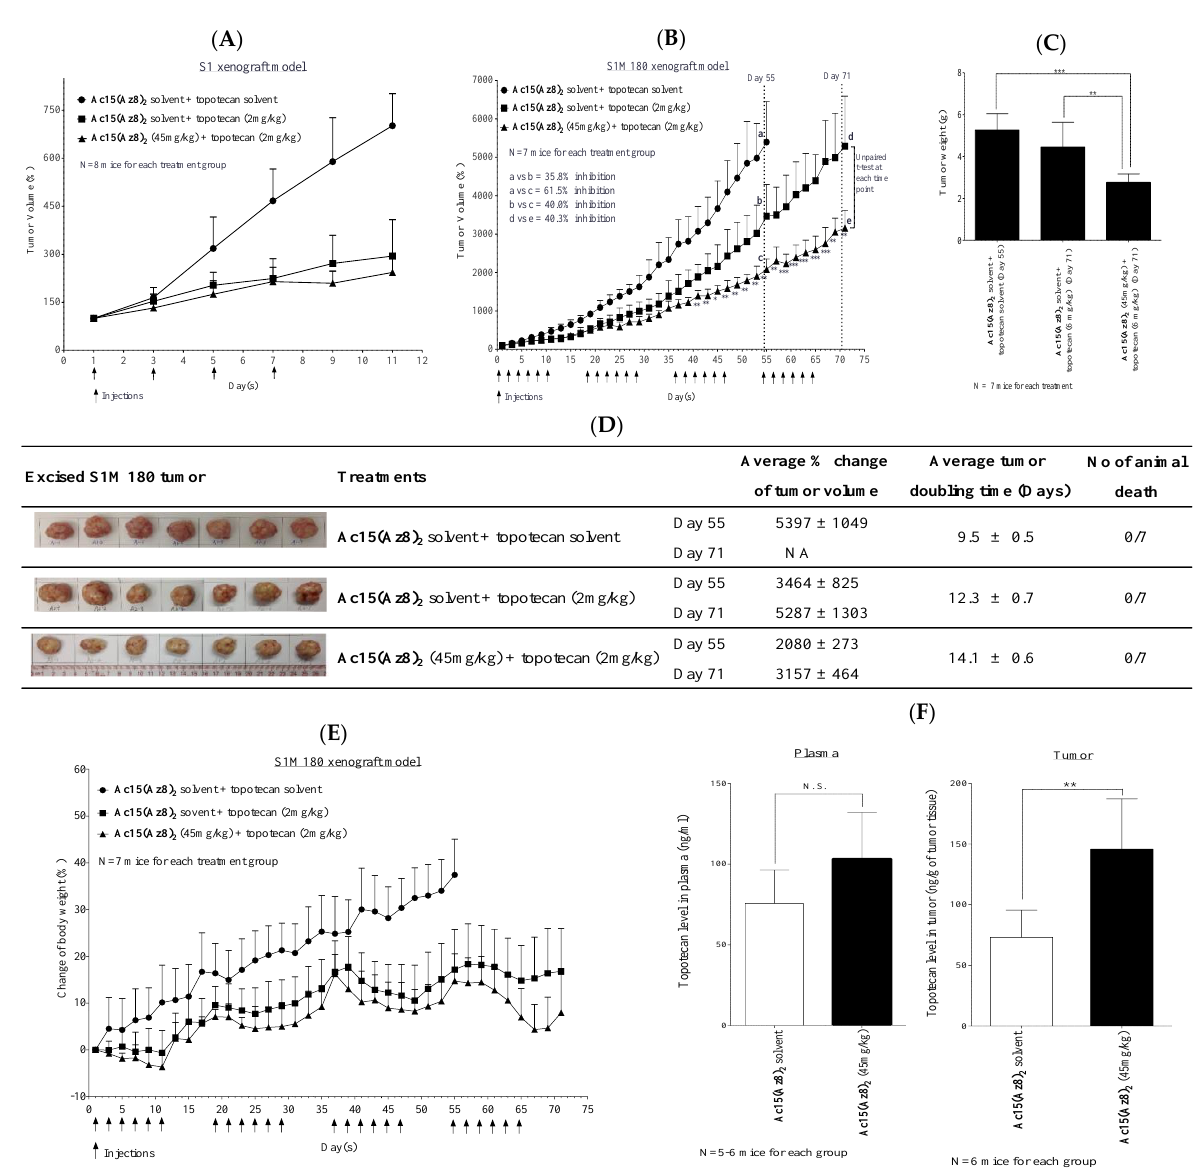
Figure 8. In vivo efficacy of Ac15(Az8) 2 in reversing BCRP-mediated topotecan resistance in S1M180 xenograft. ( A ) S1 xenograft. ( B ) S1M180 xenograft. There were 3 treatment groups in S1 and S1M180 xenograft model. Treatments were given as indicated by an arrow ( ↑ ). % of tumor volume reduction was compared among different treatment groups on days 55 and 71. a, b, and c = mean tumor volume of solvent control, topotecan alone, and combination treatment groups on day 55, respectively. d and e = mean tumor volume of topotecan alone and combination treatment groups on day 71. ( C ) Tumor weight of S1M180-bearing mice on termination day. ( D ) % change of tumor volume and tumor doubling time of S1M180 xenograft were determined on days 55 and 71. On day 55, all mice in solvent treatment group were sacrificed because of over-sized tumor. The % change in tumor volume of solvent group on day 71 was therefore labeled as NA (not applicable). Number of animal death was monitored during the efficacy study. ( E ) Body weight of S1M180-bearing mice. ( F ) To measure plasma and intratumor level of topotecan, S1M180-bearing mice were administered with 45 mg/kg (I.P.) of Ac15(Az8) 2 one hour prior to 6 mg/kg (I.P.) of topotecan administration. Five hours after topotecan administration, the mice were sacrificed. Plasma and tumor were collected for analyzing topotecan level using UPLC–MS/MS. Student’s unpaired two-tailed t -test was performed between combination group and topotecan alone group or solvent control group as indicated (* p < 0.05, ** p < 0.01, *** p < 0.001). All values in this figure were presented as mean ±